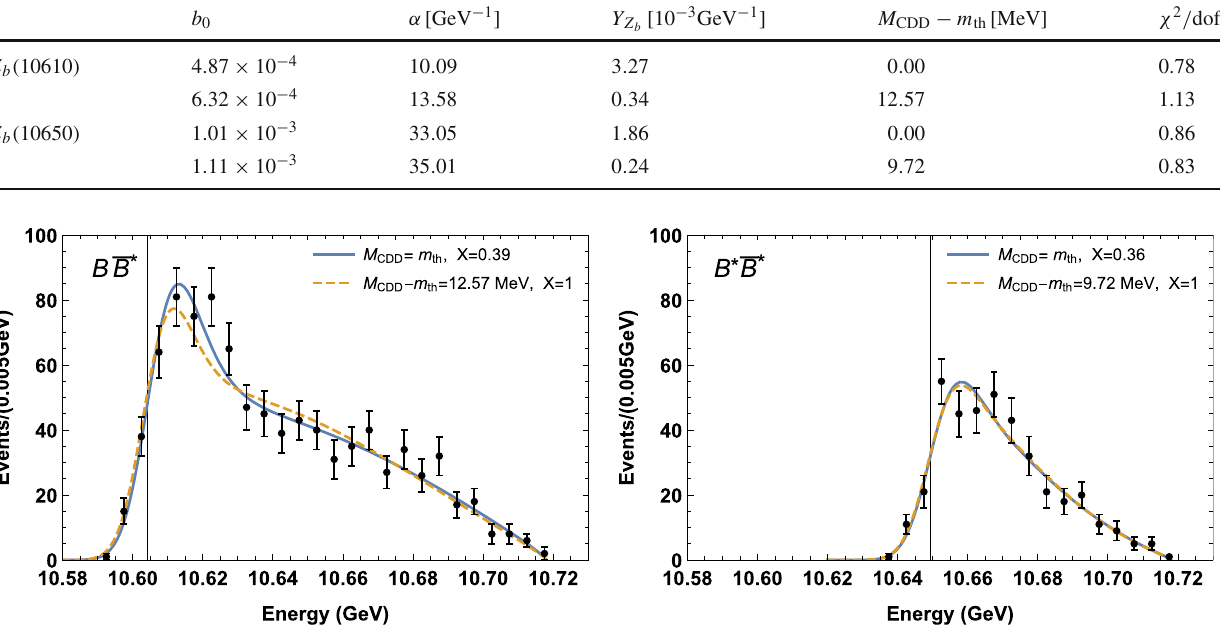
Table 1 Fit results for the resonances Z b ( 10610 ) and Z b ( 10650 ) . The fitted parameters b 0 ,α, Y Z specific values. The quantity of χ 2 per degree of freedom are listed in the last column